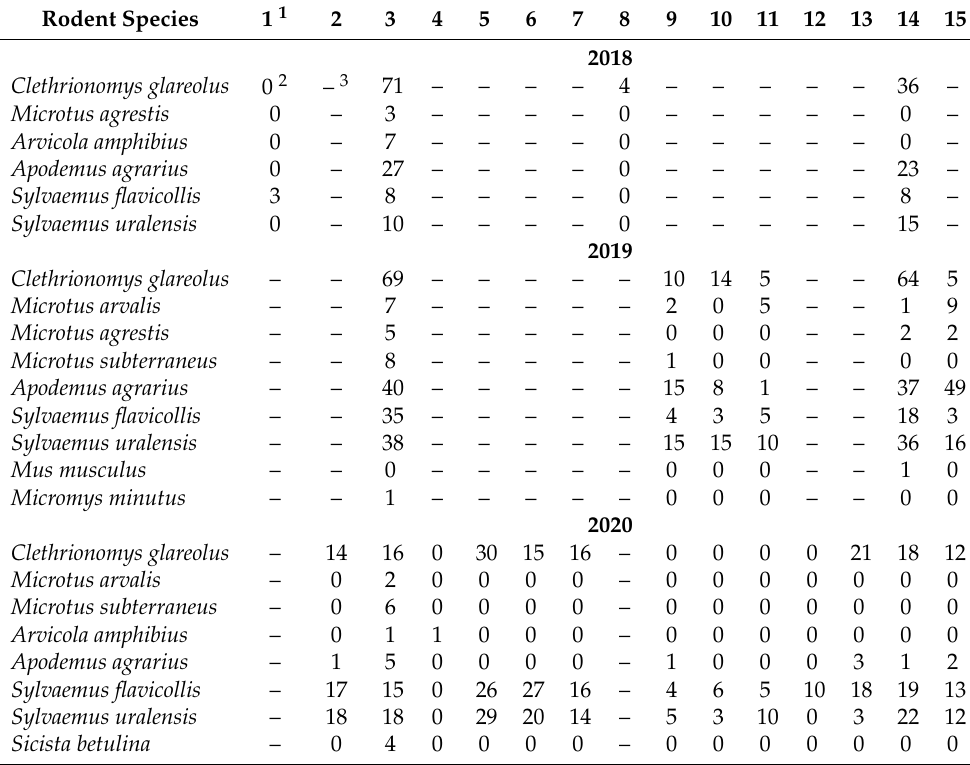
Table 1. Number of small rodents captured in the National Park “Smolny” in